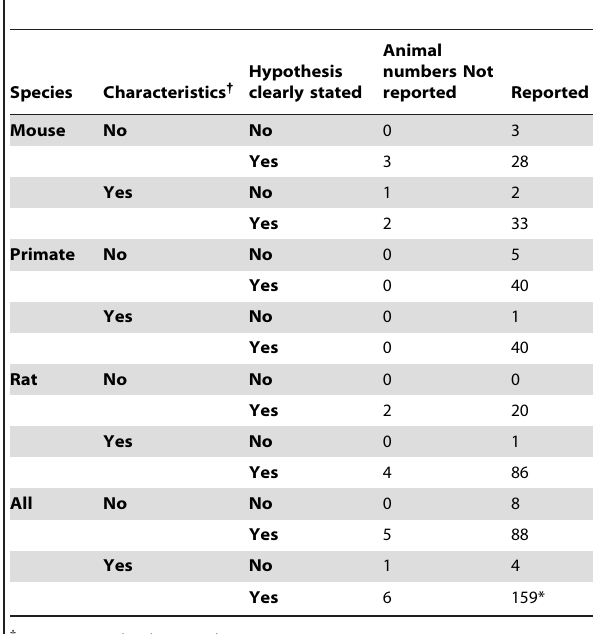
Table 12. Number of studies reporting the study hypothesis, three animal characteristics and the number of animals used.